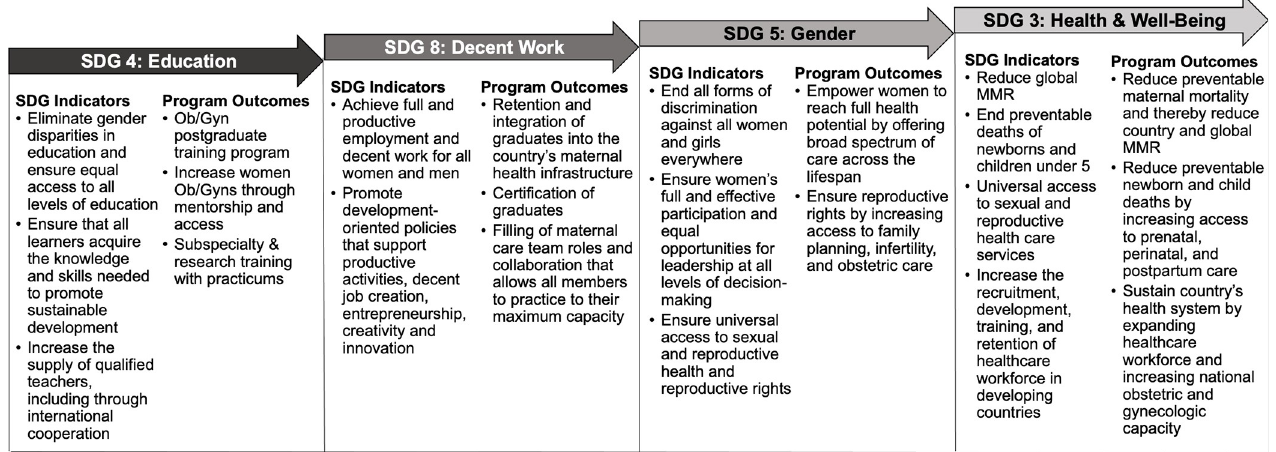
Fig 2. Sustainable development goals and targets addressed through ob/gyn postgraduate training program. Creating education opportunity (SDG 4) lays the foundation to promote decent work for graduates (SDG 8), leading to gender equity for both graduates and patients (SDG 5), and ultimately improves health and well-being, particularly maternal, newborn, and child health (SDG 3) [3].